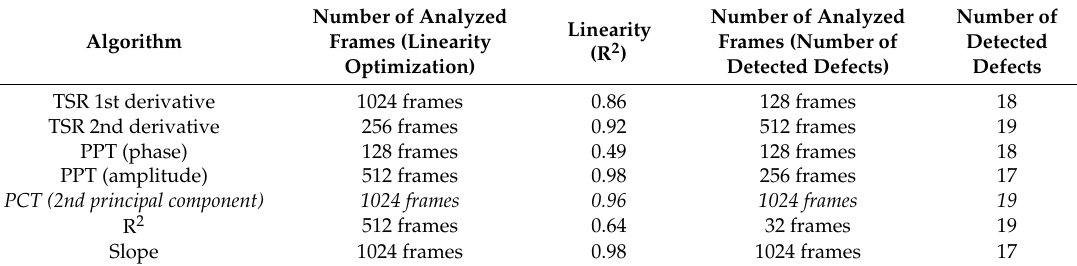
Table 6. Final comparison among the different algorithms.